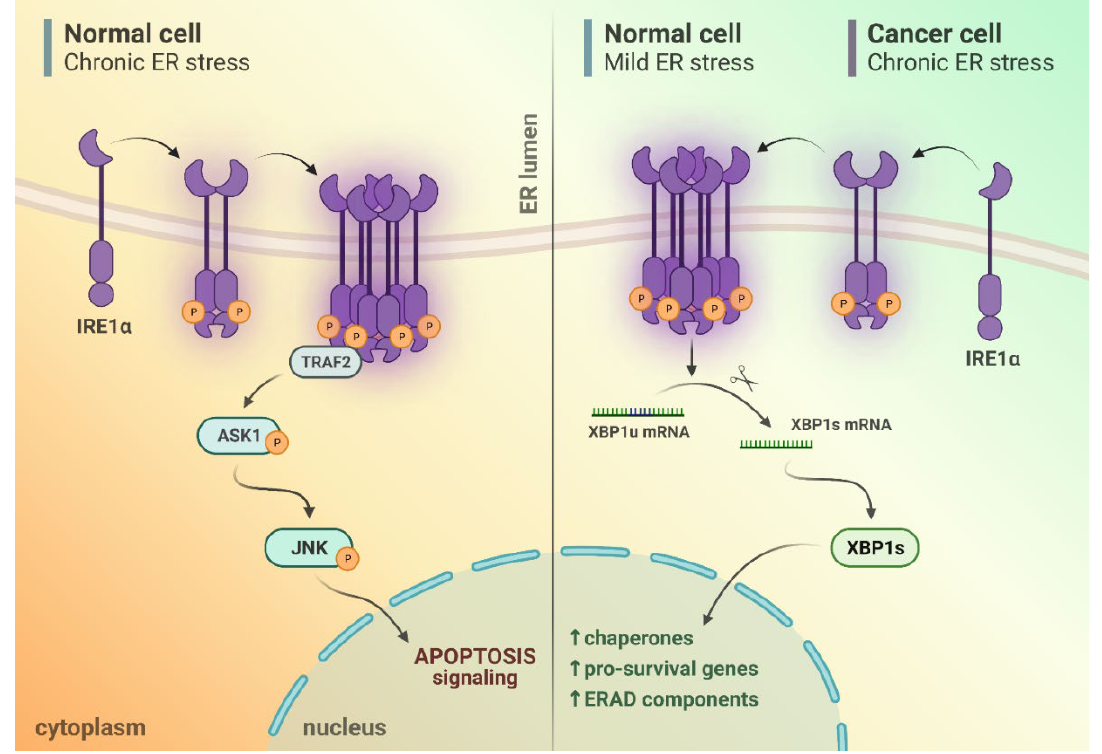
Figure 1. Different outputs of IRE1α activation depending on ER stress duration and type of affected cell: In non-cancerous cells, mild ER stress induces cytoprotective response via splicing of XBP1 mRNA, whilst chronic ER stress switches IRE1α activity rather toward induction of TRAF2/ASK1/JNK pro-apoptotic pathway. Cancer cells which exhibit chronic ER stress conditions due to their specific microenvironment are able to omit UPR-induced cell death. The intensity of IRE1α -dependent XBP1 splicing in these cells is significantly increased.